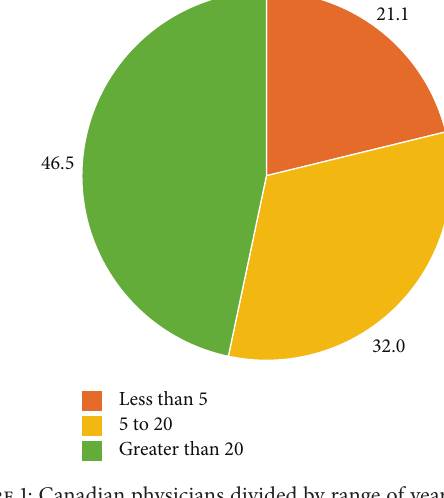
Table 1: Demographics of survey respondents.